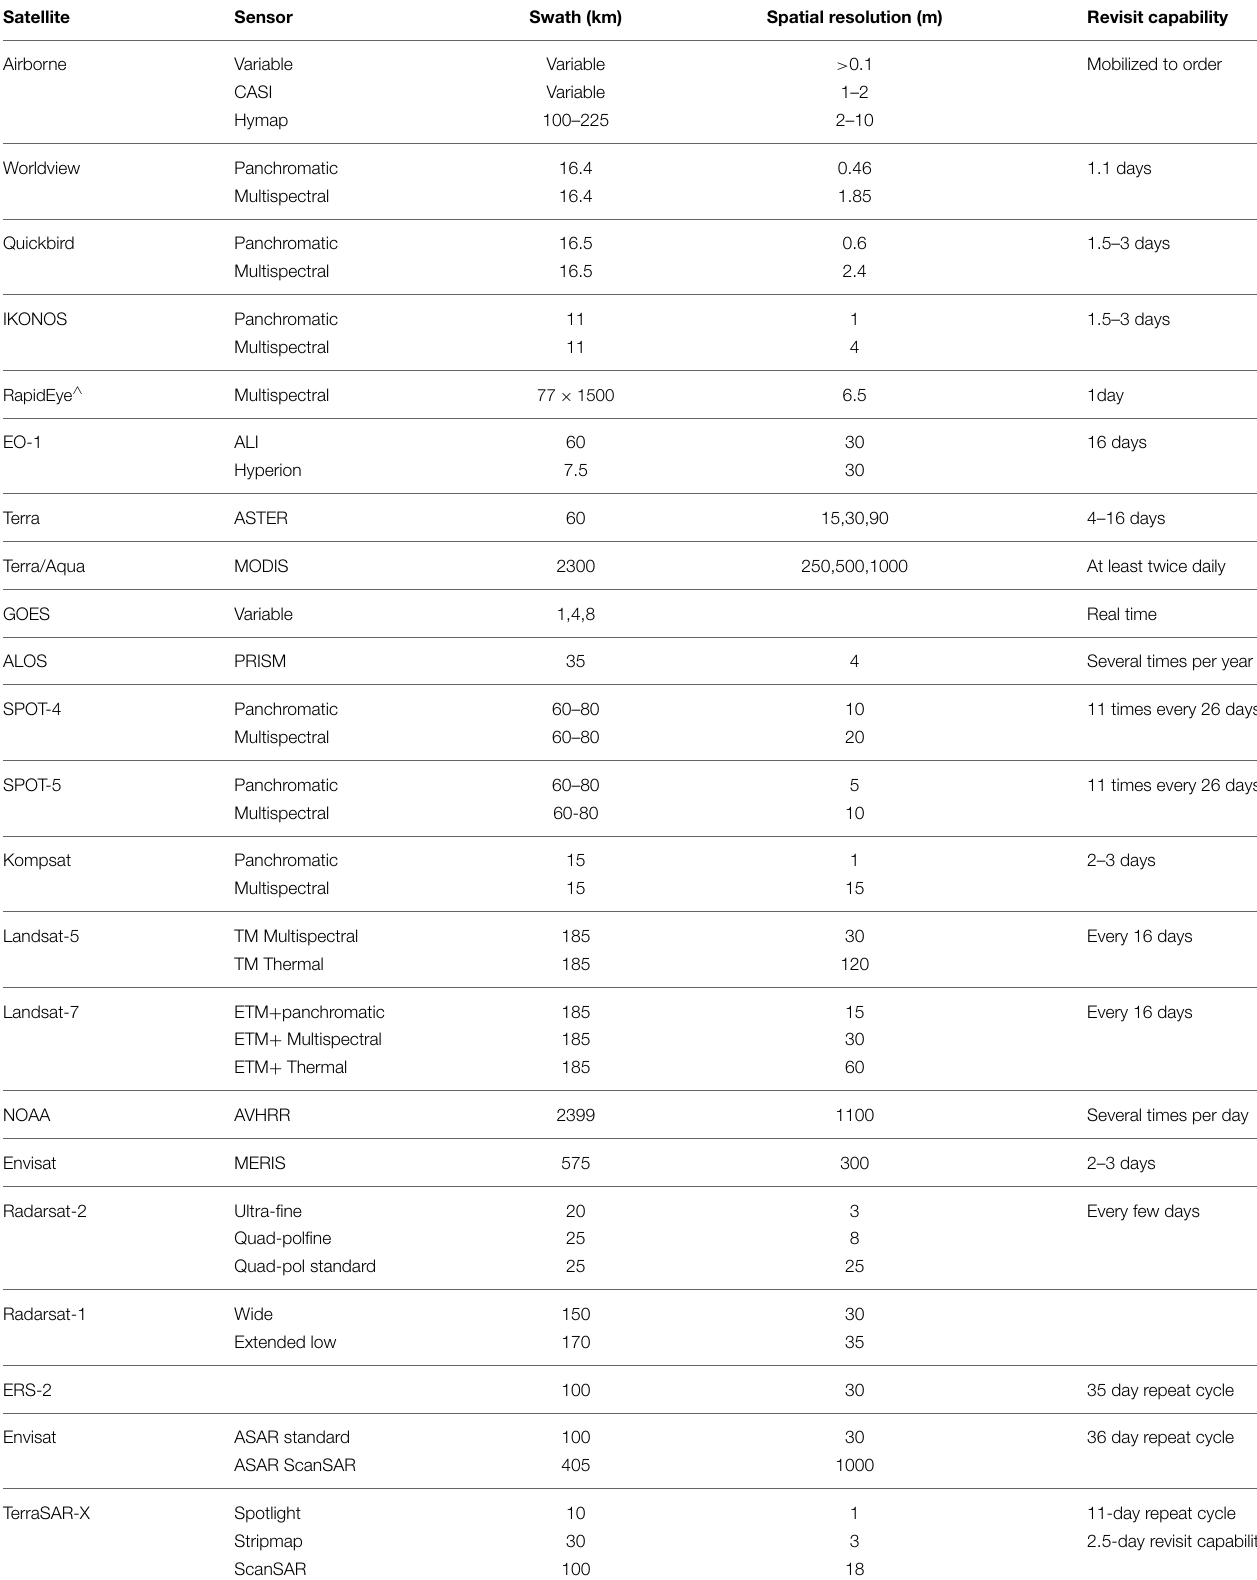
TABLE 1 | Summary of the characteristics of satellites often used in environmental information